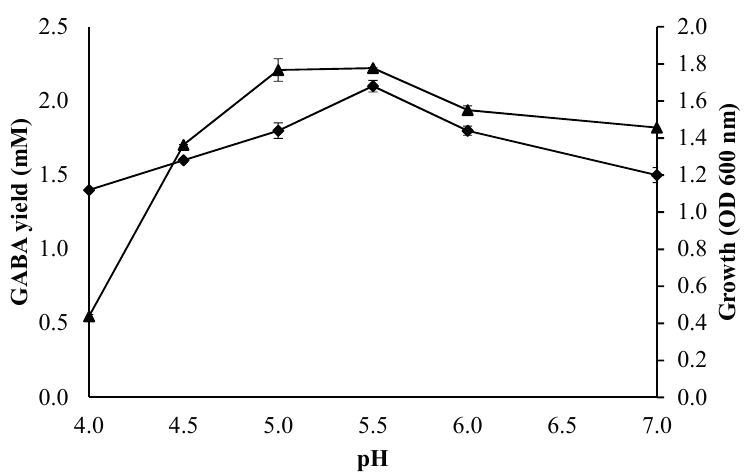
Figure 4. Effect of initial pH on growth profile and GABA production by Lactobacillus plantarum Taj-Apis362. Culture conditions were fixed as follows: initial glutamic acid concentration, 50 mM; culture temperature, 30 °C; and incubation time, 60 h. Symbols: ( ▲ ) growth; ( ♦ ) GABA. The vertical bars represent the SD from 3 replicates.